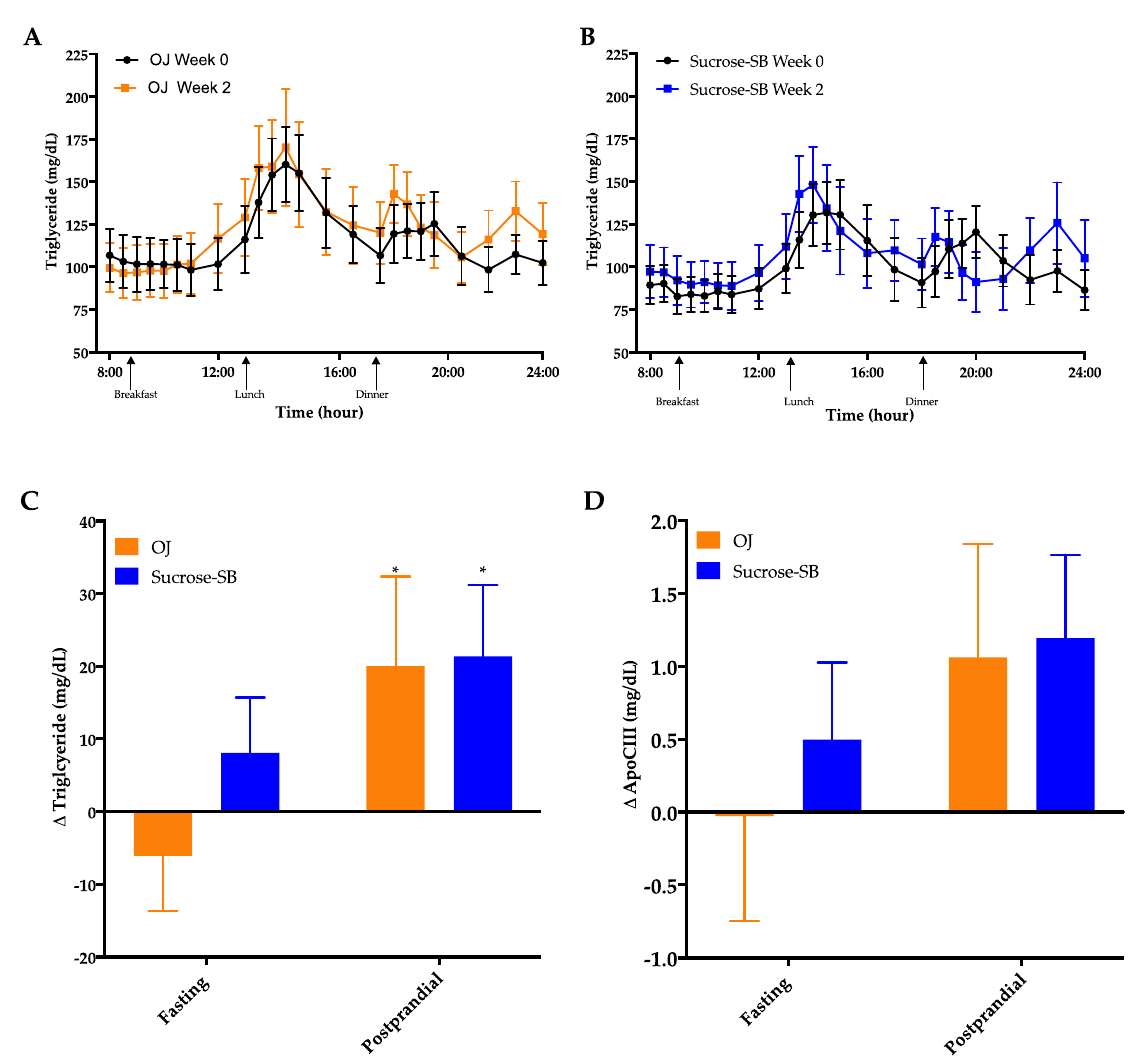
Figure 4. Sixteen-hour circulating triglyceride (TG) concentrations before (black line) and after (blue line) consumption of either ( A ) OJ or ( B ) sucrose-SB for two weeks. Changes in fasting and postprandial ( C ) triglyceride and ( D ) ApoCIII after two weeks of OJ or sucrose-SB consumption. * p < 0.05, LS mean of change different from zero. Apolipoprotein CIII (ApoCIII).